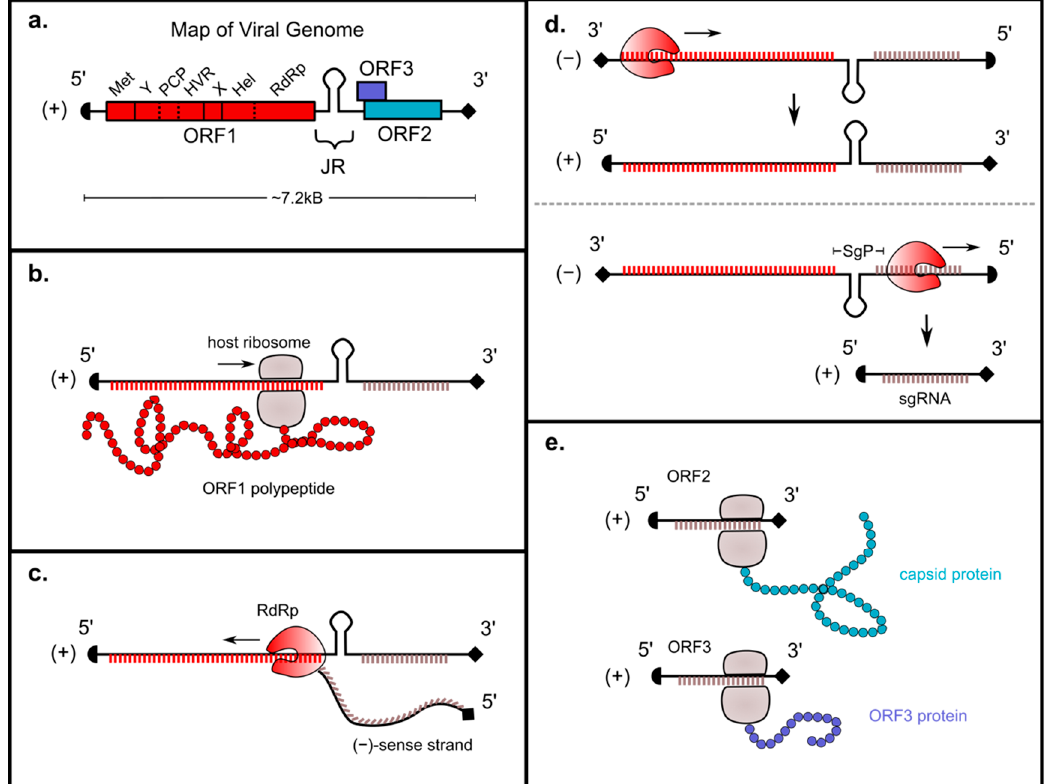
Figure 1. Genomic organization and replicative mechanism of hepatitis E virus. ( a ) Map of HEV genome including domains encoded by ORFs 1–3. ( b ) After viral entry and uncoating, ORF1 is translated by host ribosomes into a polyprotein that includes the RdRp. ( c ) The RdRp transcribes a ( − )-sense full-length genome from the ( + )-sense strand. ( d ) The ( − )-sense genome is a template for transcription of two ( + )-sense RNAs: a full-length transcript and a subgenomic (sg) RNA encoding ORFs 2 and 3. The latter is transcribed from the subgenomic promoter (SgP). ( e ) The capsid protein and HEV viroporin are translated from the subgenomic RNA.